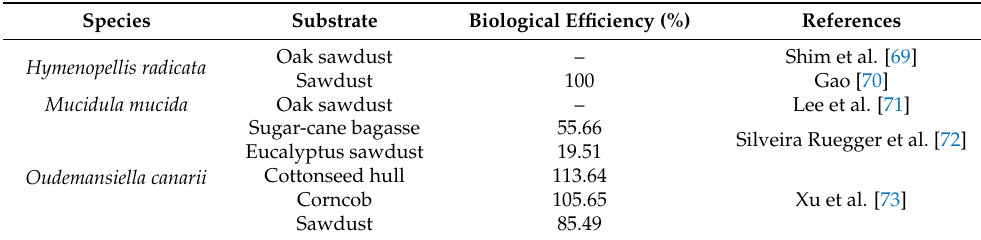
Figure 4. Basidiomata of Hymenopellis raphanipes cultivated in China and in the Mae Fah Luang (MFU) laboratory, Thailand. ( a ). Mature basidiomata, ( b ). Young basidiomata, ( c ). Basidomata from bags. Photos from Yu Wei and A.G. Niego. Table 2. Some cultivable OX species on different substrates and (%) biological efficiency, as effectiveness of mushroom strain growth in the given substrate. Biological efficiency refers to the percentage of ratio of fresh mushroom weight over the dry weight of the respective substrate.